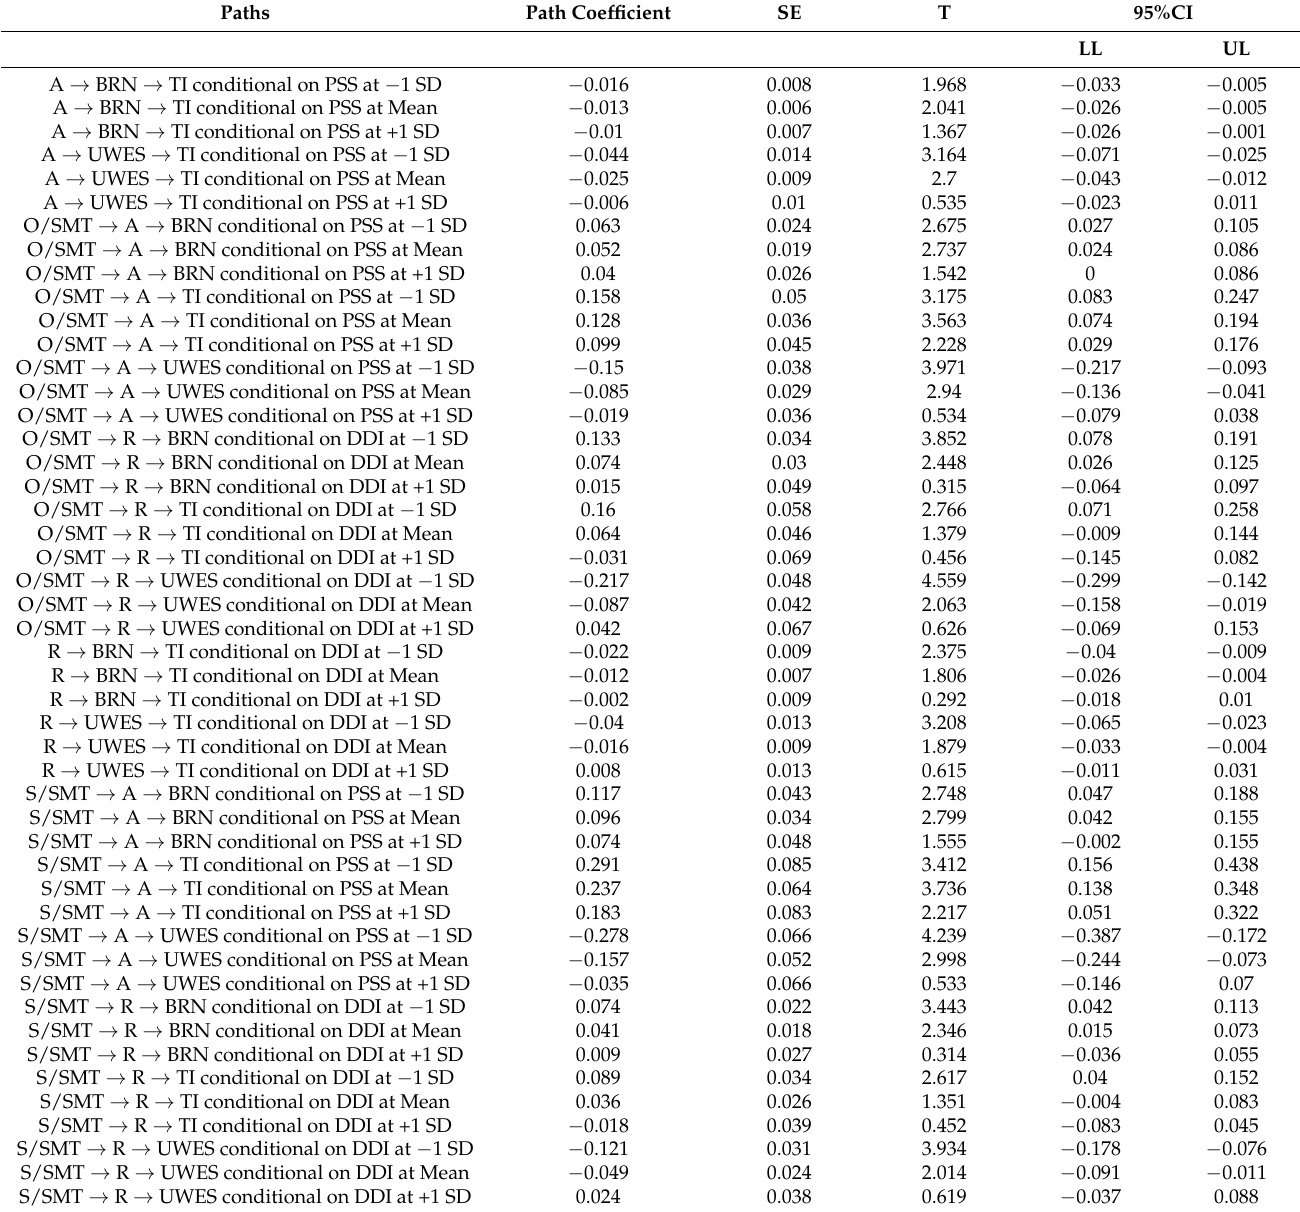
Table A12. Moderation Analyses—Other Conditional Indirect Effects.